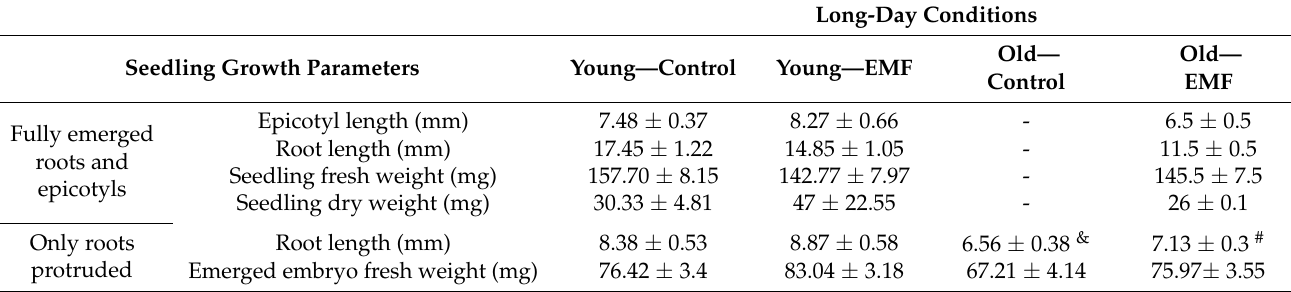
Table 3. The effects of EMF on growth parameters of field bean seedlings cultivated in Petri dishes for 6 days under long-day